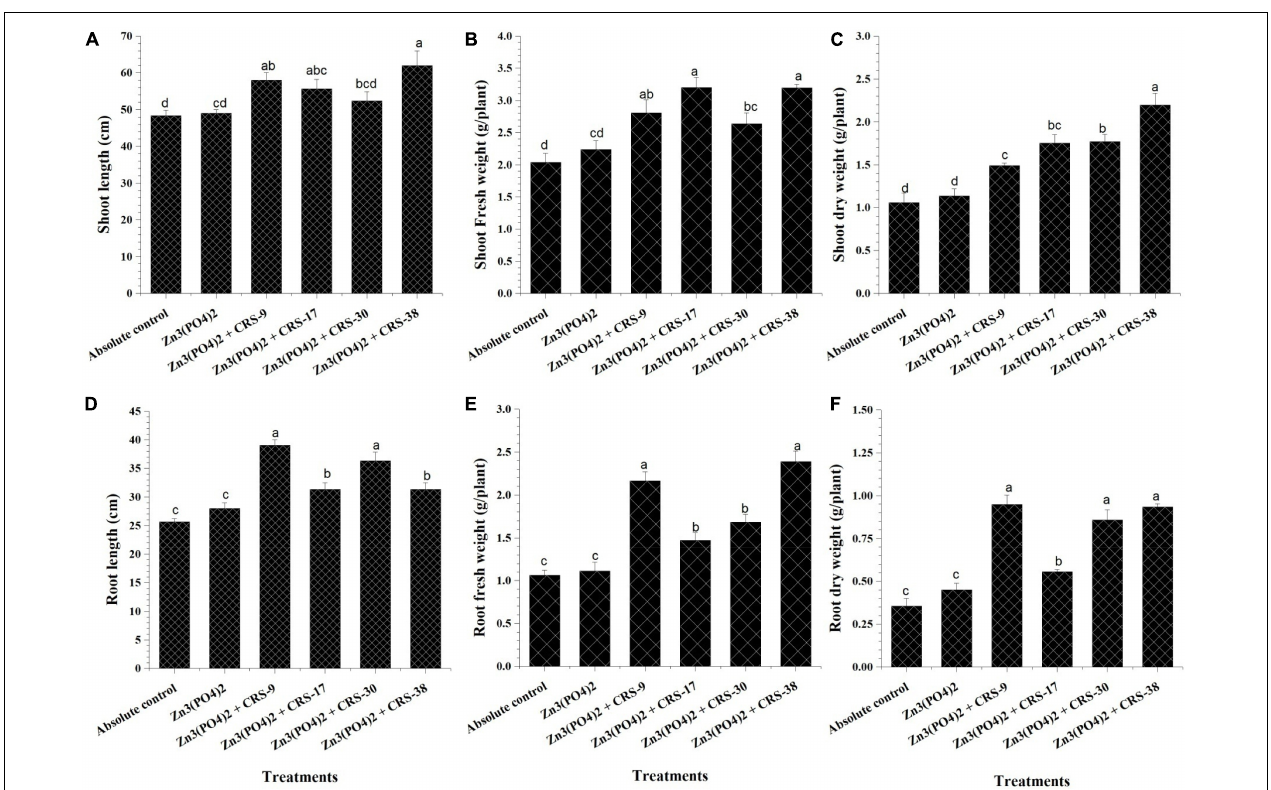
FIGURE 7 | Effect of zinc-solubilizing rhizobacterial inoculation on growth parameters of plants harvested after 120 days (second set). (A) Shoot length, (B) fresh weight of shoots, (C) dry weight of shoots, (D) root length, (E) fresh weight of roots, (F) dry weight of roots in comparison with absolute control. Data are mean ( n = 5), and the vertical bar represents standard deviation. Data with different letters show a significant difference in column data in the randomized block design test at p < 0.05 under Duncan’s multiple range